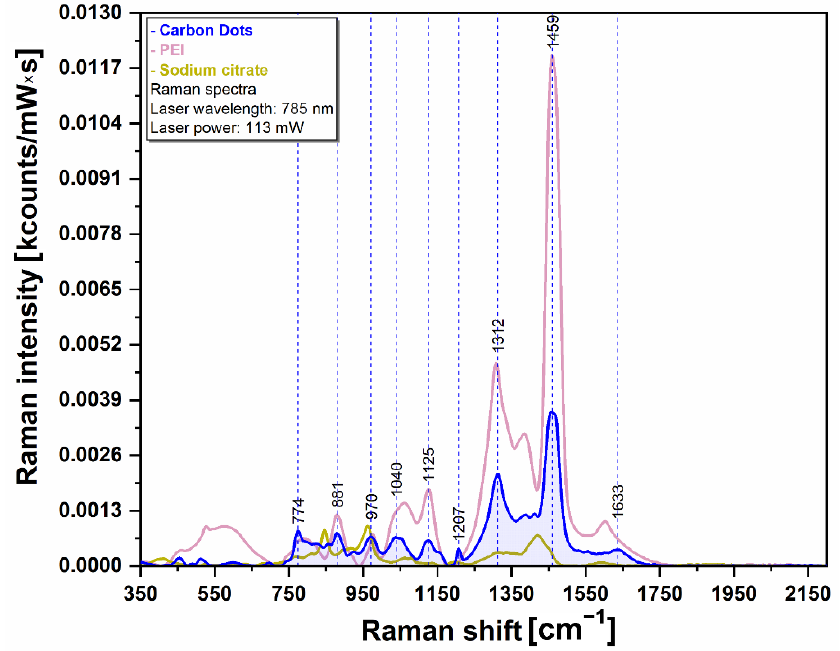
Figure 12. Raman spectra of the CQDs (blue) and of the precursors sodium citrate (light brown) and PEI 1.2 K (light pink) in the spectral range 350–2150 cm − 1 . All the spectra were baseline corrected for better clarity.